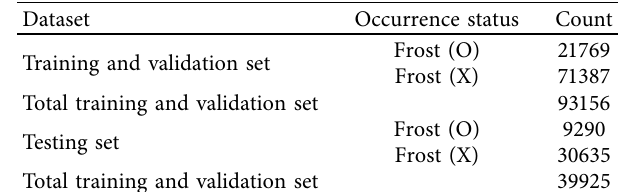
Table 3: Count of frost occurrence and nonoccurrence in the dataset.